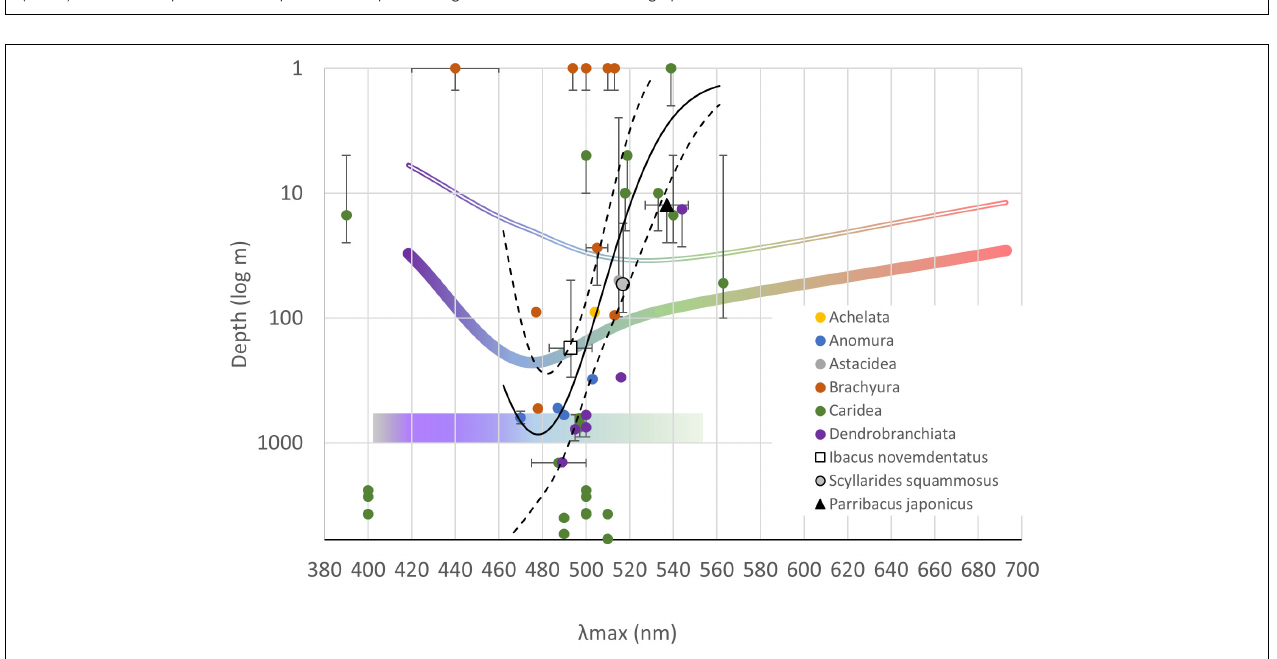
FIGURE 10 | Peak spectral sensitivities ( λ max ) and the inhabited depths for slipper lobsters and other decapods. The mean peak wavelengths are shown along the horizontal axis; the error bars indicate maximum and minimum range of peak wavelengths that have been reported for each species (see Supplementary Data 4 for details). The means of inhabiting depth are shown along the vertical axis, and the error bars indicate the range of depths (in log scale) reported in the literature or cited in an online database (https://www.sealifebase.ca/). The colored curves show sunlight penetration in the open ocean (thick line) or coastal waters (double thin line) (re-plotted from Mohamed, 2019). The colored bar at 1,000 log m shows the bioluminescence spectra of creatures found between 500–1,000 m (Johnsen et al., 2012). A Gaussian regression curve (solid black line) was fitted to the plots (except for dichromatic species) by the least squares method ( R 2 = 0.30). The 90% confidence level is shown (dashed